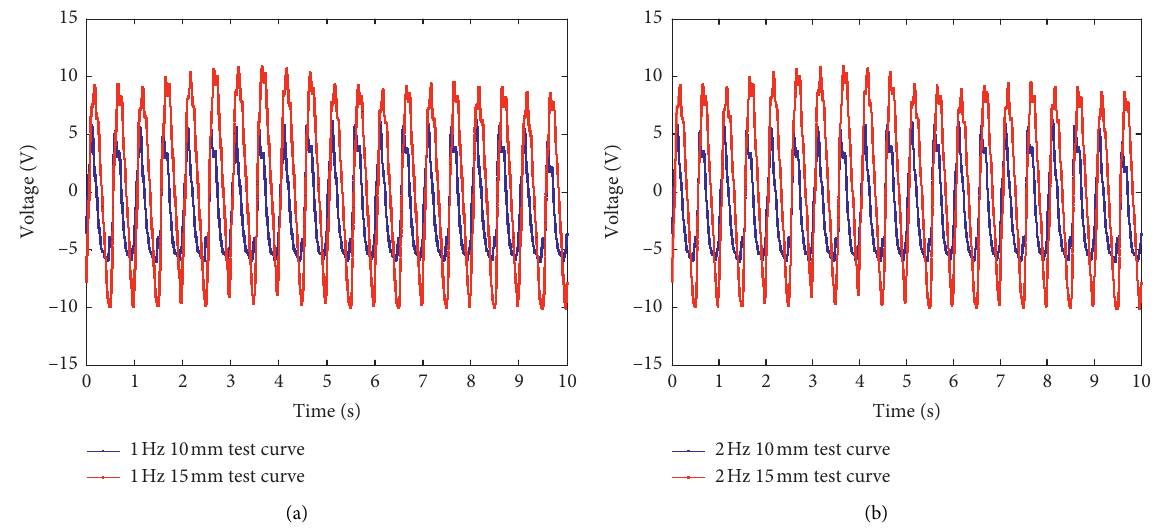
Figure 17: Energy feedback voltage of electromagnetic actuator under different